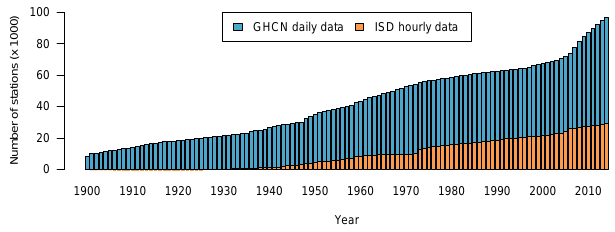
Figure 1. Time series of the worldwide station data availability in the 20th and 21st century according to the global ISD and the GHCN data